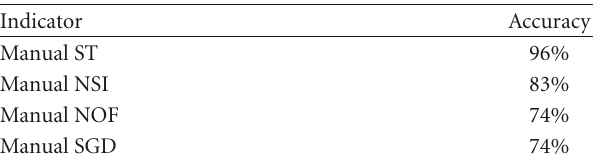
Table 2: Dominance classification results using independent manually-labeled